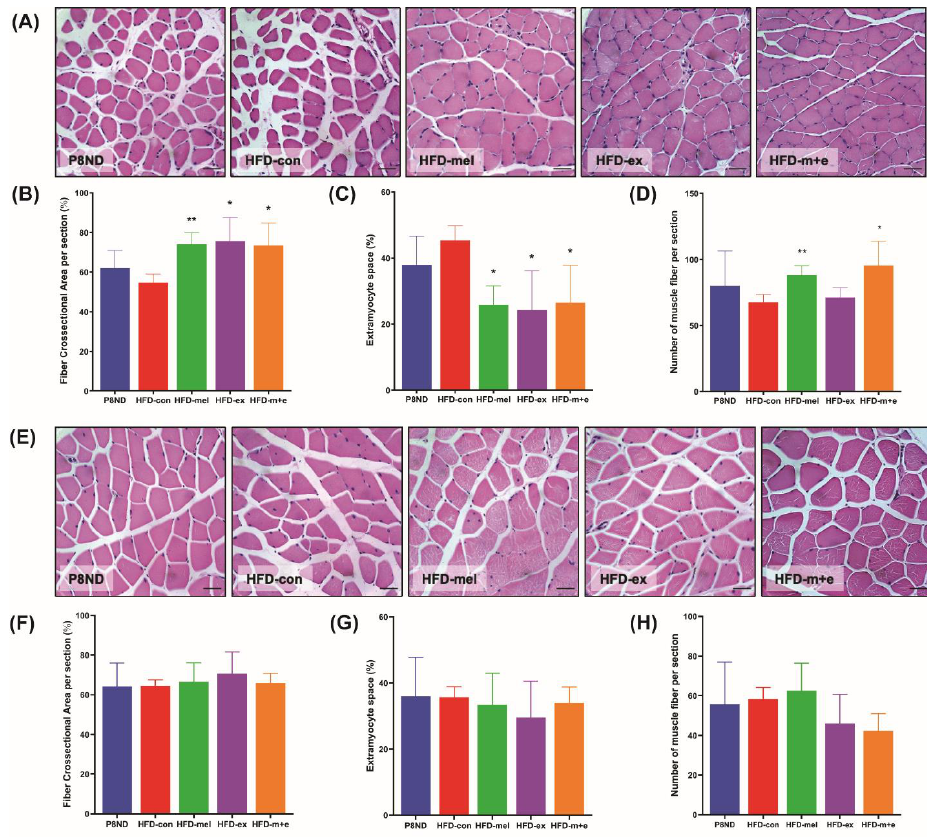
Figure 2. Effects of melatonin and exercise training on skeletal muscle morphological changes: Representative hematoxylin and eosin staining illustrating the effects of melatonin and/or exercise training on myofiber morphology in the ( A ) soleus and ( E ) white gastrocnemius muscles. Bar graphs illustrate ( B , F ) the percentage of muscle fiber cross-sectional area (CSA), ( C , G ) the percentage of extramyocyte space, and ( D , H ) the number of muscle fibers per section in the soleus and white gastrocnemius muscles, respectively. Data are the mean ± SD (n = 4 – 5 mice per group). Scale bar = 25 μ m; * p < 0.05, ** p < 0.01 vs. HFD-con by unpaired t -test.